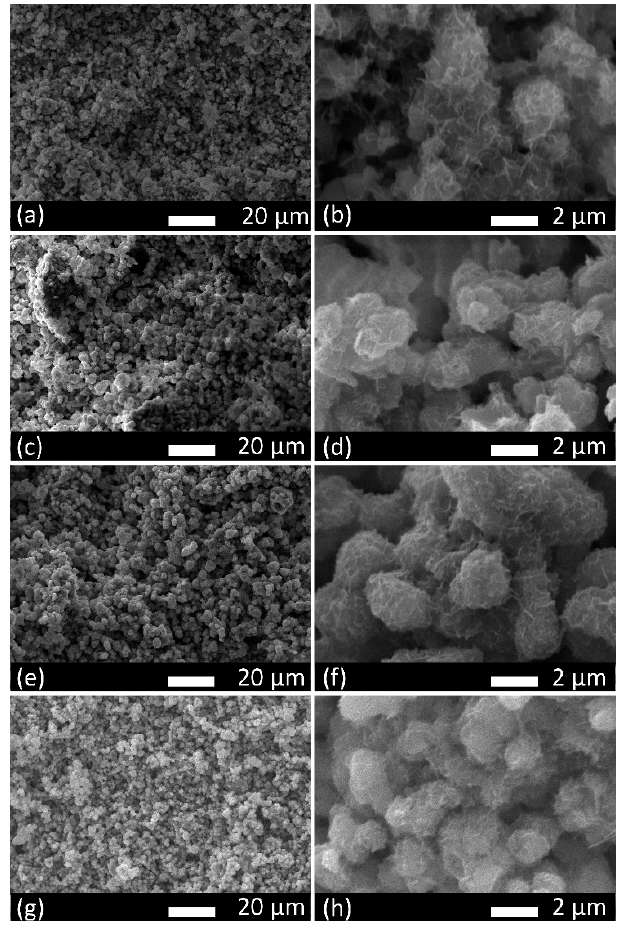
Figure 5. SEM images of C2S and Sr-C2S cements after curing in a constant-temperature shaking water bath at 37 °C for 14 days: ( a , b ) C2S; ( c , d ) Sr1-C2S; ( e , f ) Sr5-C2S; ( g , h ) Sr10-C2S. Materials 2018 , 12 , x FOR PEER REVIEW